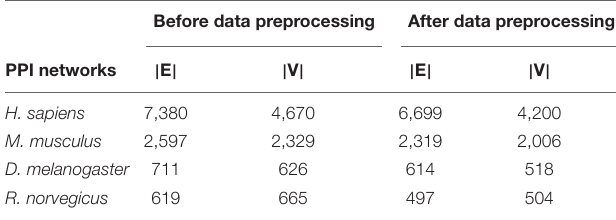
TABLE 3 | The PPI networks.